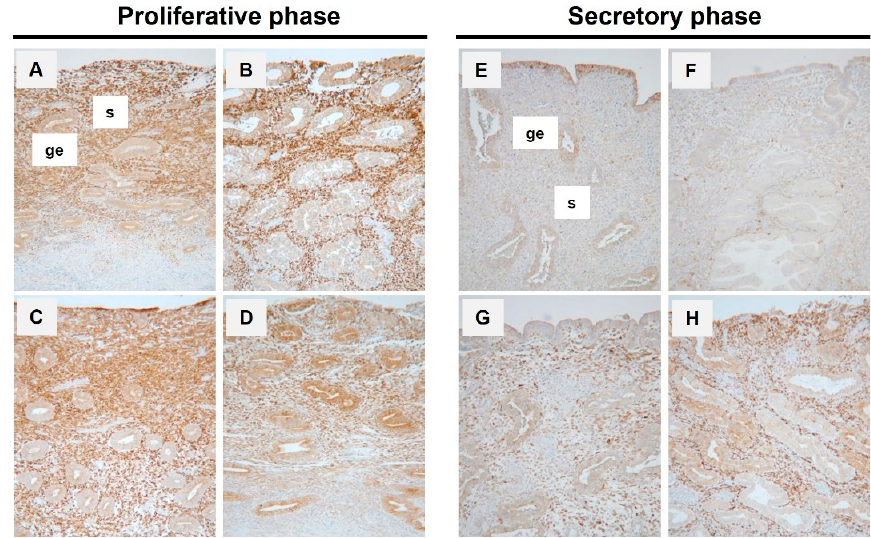
Figure 1. Expression of PGRMC1 in the endometrium. Sections of human endometrium in the proliferative ( A – D ) (n = 4) and secretory ( E – H ) (n = 4) phases were subjected to immunostaining for PGRMC1 (brown staining) and counterstained with hematoxylin. ge: glandular epithelial cells, s: stromal cells.